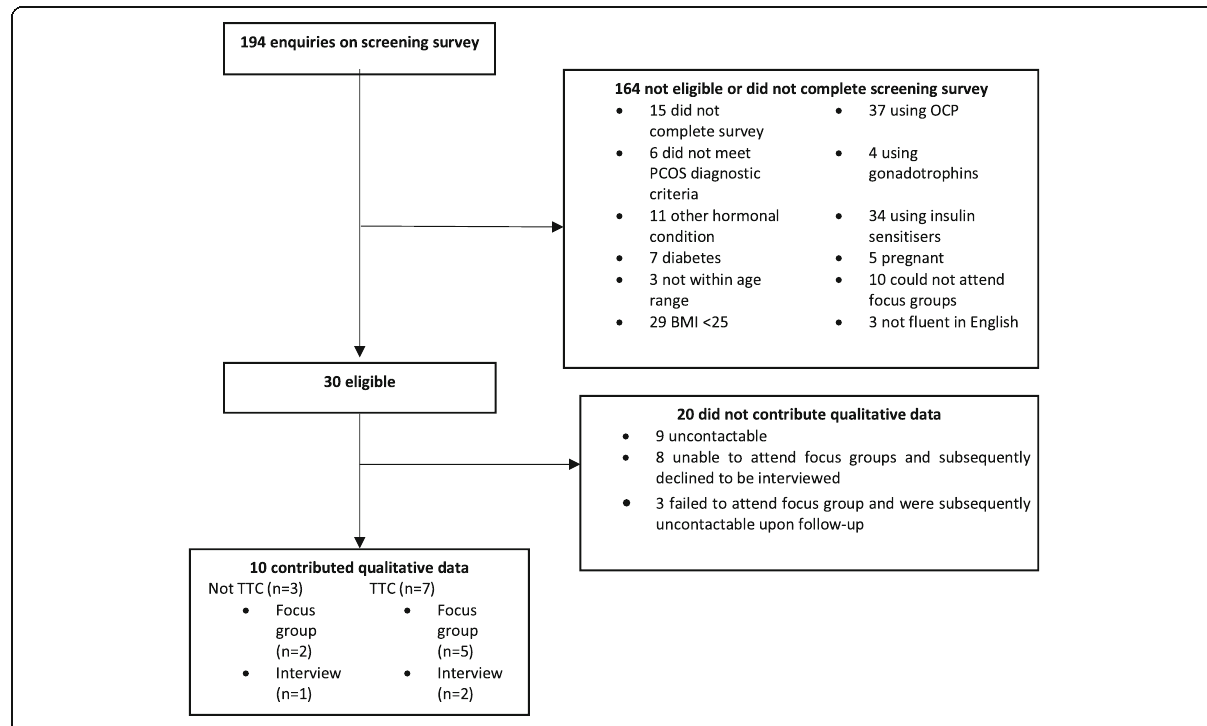
Fig. 1 Flow of participants through the study. TTC = Trying To